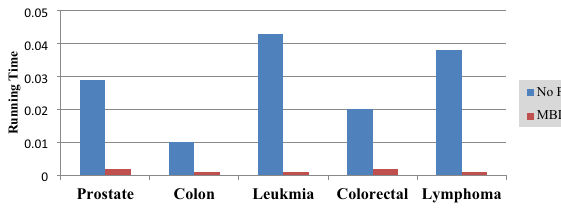
Fig. 5 CPU Runtime Comparison